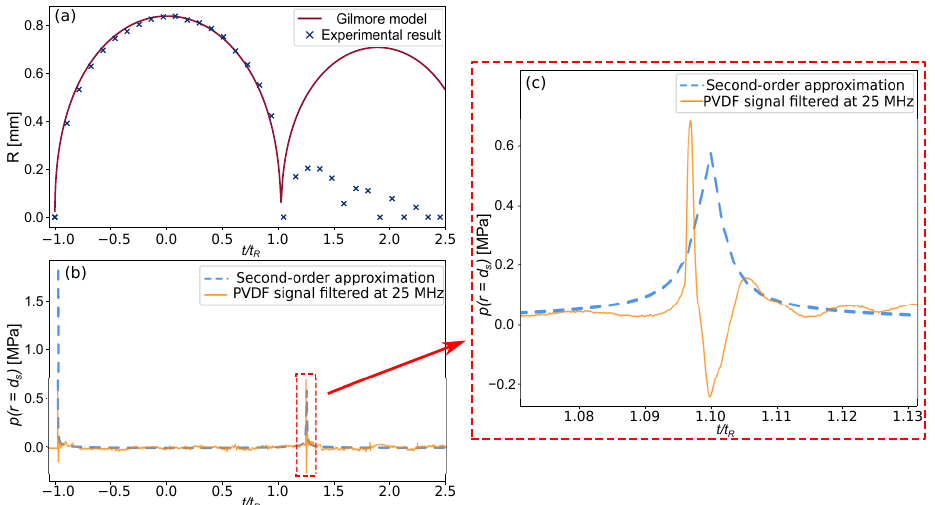
Figure 9. ( a ) Evolution of the bubble radius: comparison between experimental data and the Gilmore model. ( b ) Comparison of the pressure evolution with γ = 10.1 from the PVDF sensor and wave propagation model. ( c ) Zoom of the peak pressure caused by the bubble